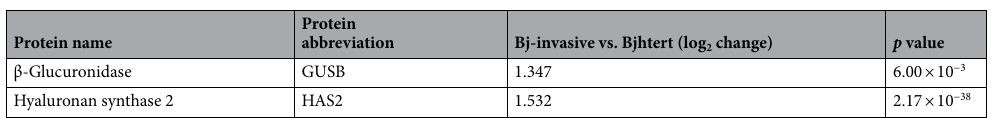
Table 1. Up-regulated hyaluronan-related genes in invasive (Bj-invasive) relative to control child fibroblasts (Bjhtert).